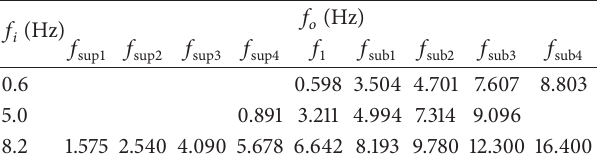
Table 1: Output frequency of voltage response.